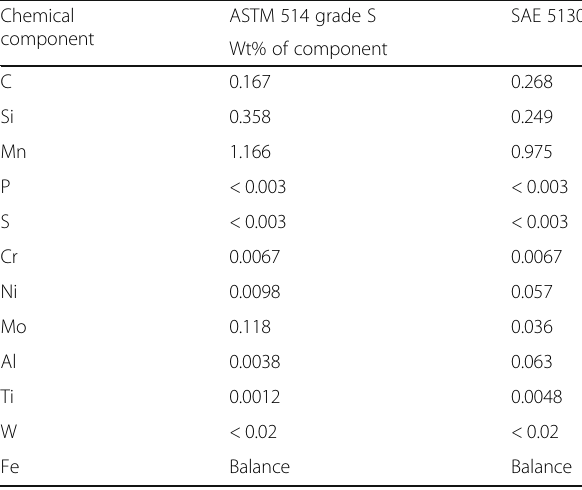
Table 1 Chemical composition of the used steels Chemical component